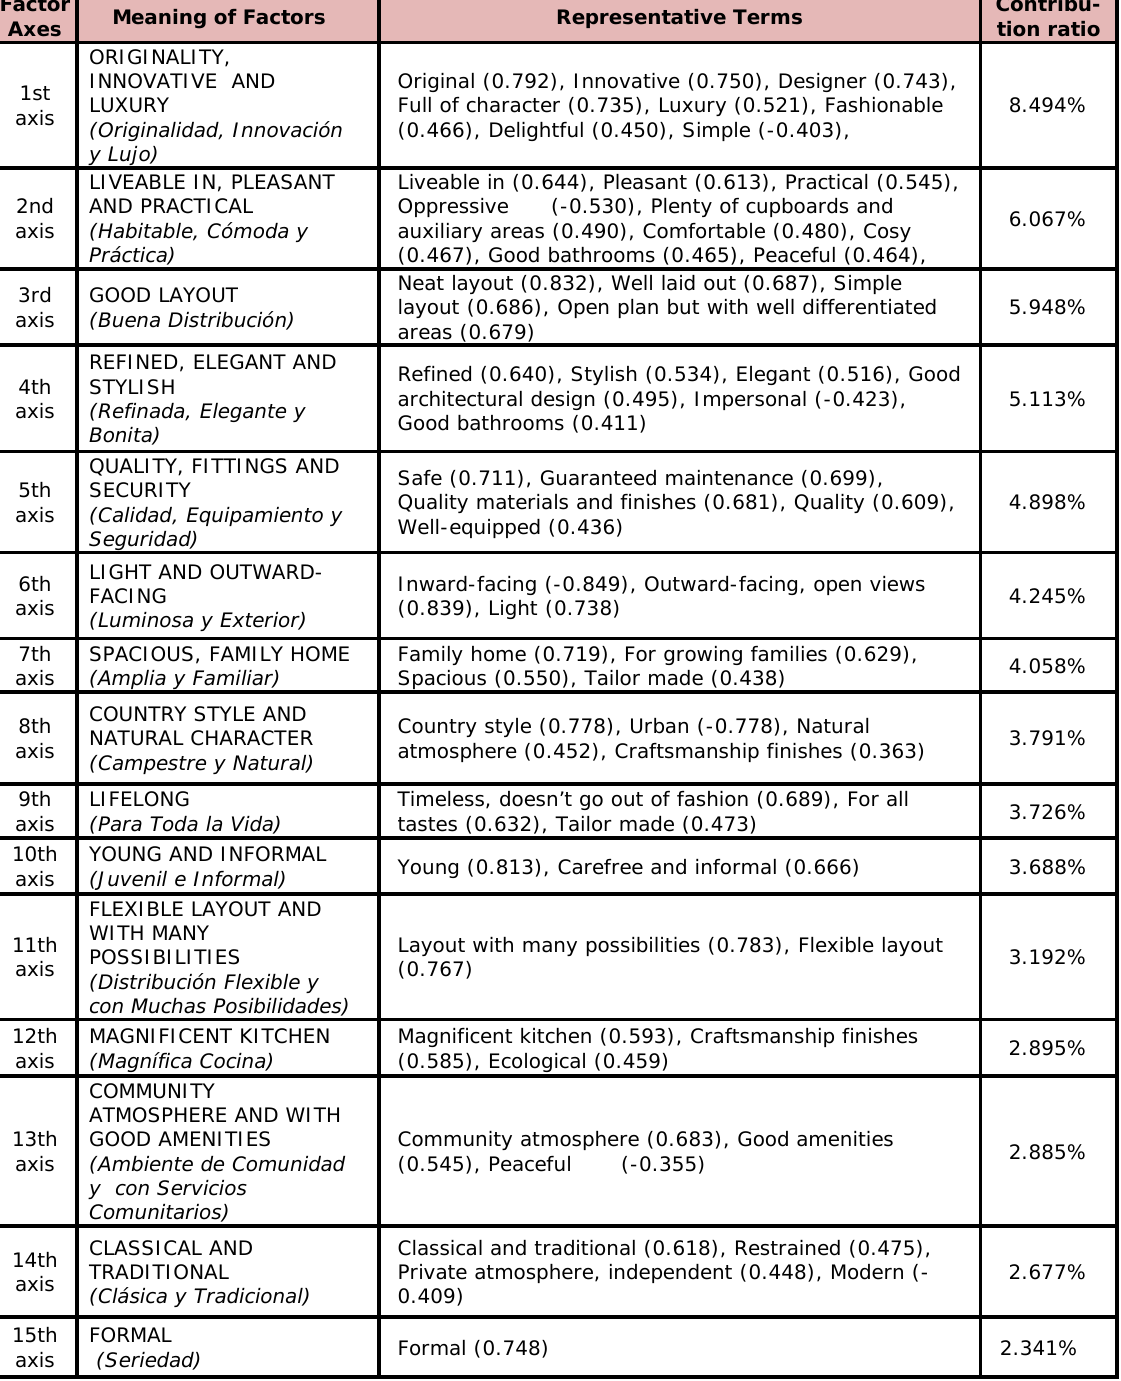
Table 4. “Range of meaning of semantic axes and representative terms-Men (In brackets, original Spanish words)”. Source: